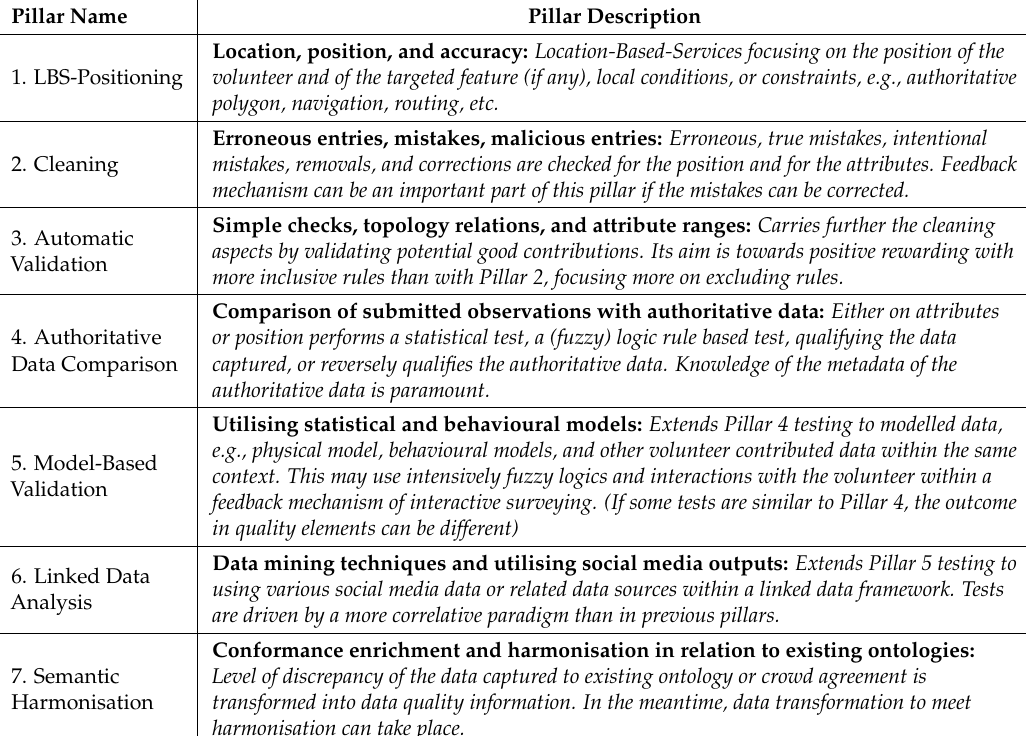
Table 2. The Seven Pillars of Quality Controls in Crowdsourcing